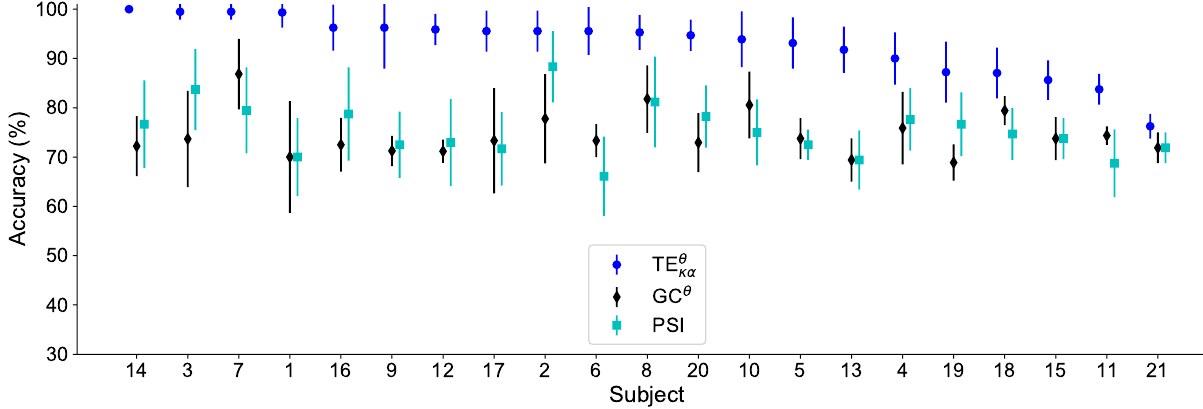
Figure 11. Highest average classification accuracy for each subject in the WM database. The subjects are ordered from highest to lowest performance according to the accuracies obtained for the TE θ κα -based